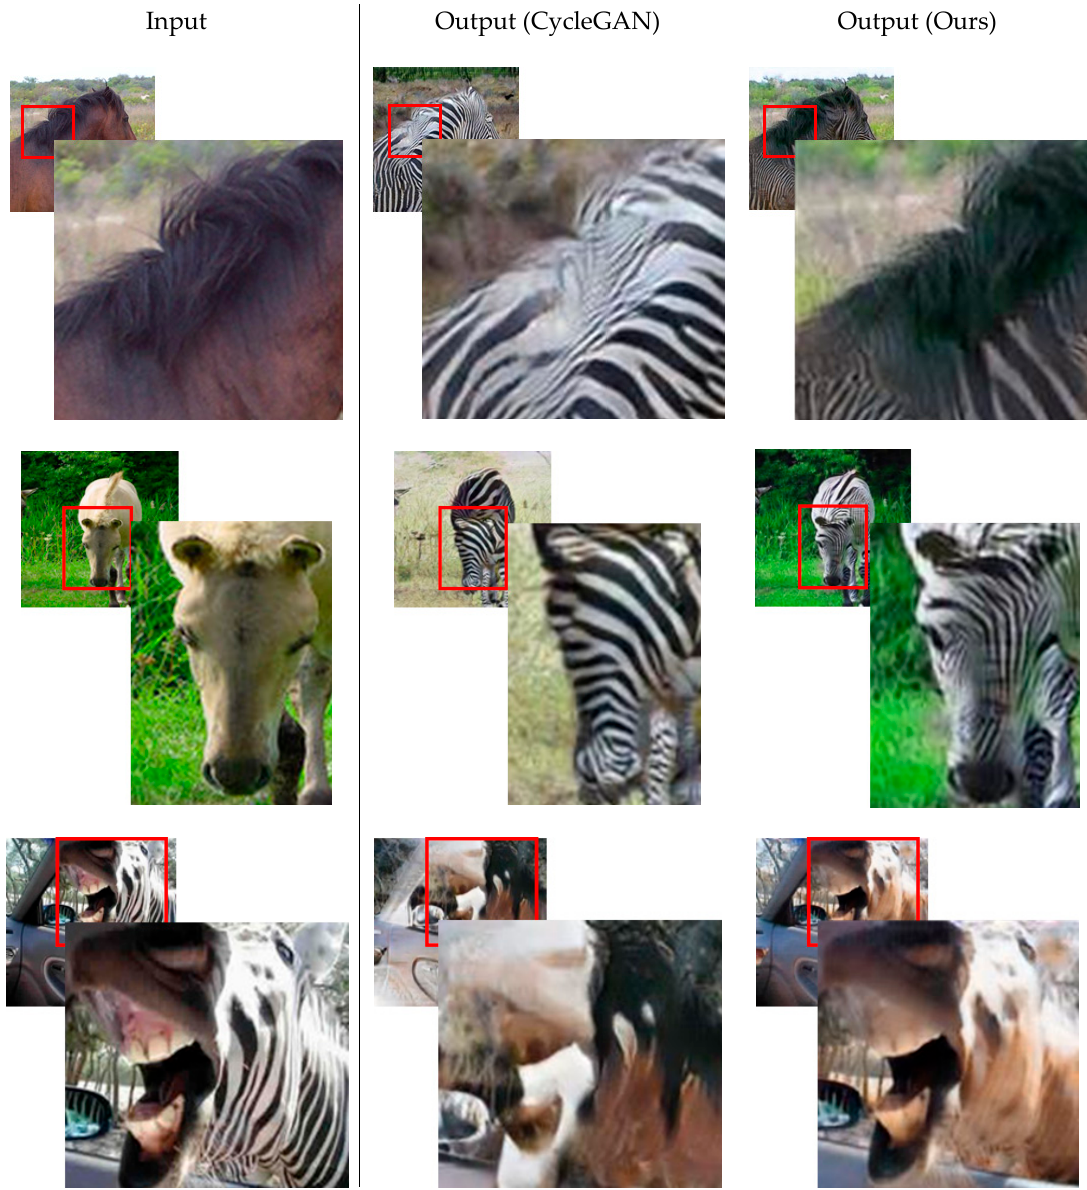
Figure 8. Detailed portions of translated pictures. Enlargements of the results of the baseline (CycleGAN) reveal mistranslation from the horse hair to zebra patterns, elimination of detailed features like eyes and nose, and inverting (or blurring) colors. Our model is more stable than the baseline because it makes translations while preserving the main characteristics of all the objects in the image, including eyes, nose, hair, and colors.